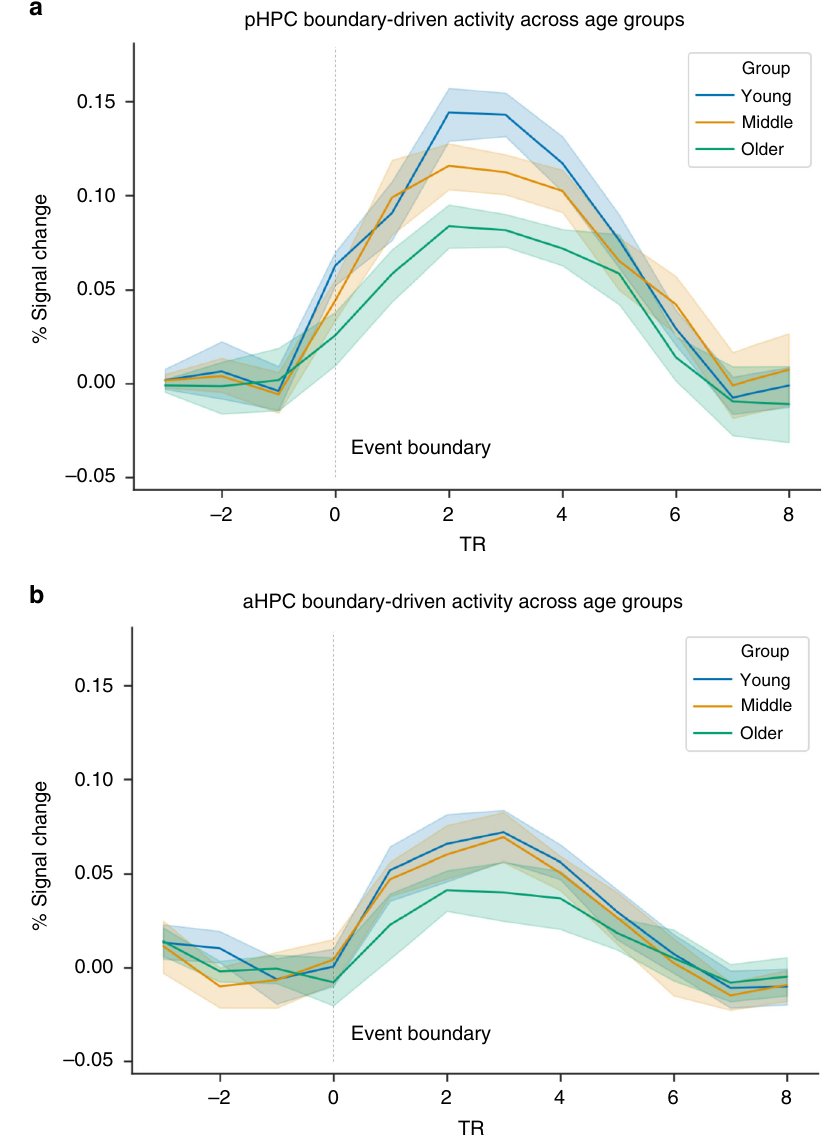
Fig. 2 Time-course of boundary-evoked response in posterior hippocampus across age groups. The time-courses of BOLD responses (FIR) are highly comparable across groups, indicating reduced pHPC boundary-evoked responses with age rather than a fundamentally different shape of the hemodynamic response. a pHPC, b (all p < 0.05 corrected), whereas the effect was driven by the (Fig. 4). Given the preferential connectivity of pHPC to the PM Network 26 , we predicted that PM regions, like pHPC, would be driven by event boundaries. Like pHPC, we found signi fi cant boundary-evoked activity throughout PM network regions: angular gyrus (ANG; t (545) = 37.26, p = 5.61e − 152 ), posterior medial cortex (PMC; t (545) = 32.69, p = 5.61e − 130 ), and para- hippocampal cortex (PHC; t (545) = 27.58, p = 5.61e − 105 ). Also in line with pHPC, we observed signi fi cant negative correlations with age in the same regions: ANG ( r = − 0.212, p = 5.56e − 07 ), PMC ( r = − 0.174, p = 4.37e − 05 ), PHC ( r = − 0.131, p = 0.002) (Fig. 5a, c, e). Broken down by groups, we found signi fi cant (Fig. 5g, i). Broken down into age groups, we found a signi fi cant differences in boundary-evoked activity across age groups in each effect of age in mPFC ( F (2,543) = 6.776, p = 0.001, η 2 = 0.025), region: ANG ( F (2,543) = 19.564, p = 6.24e − 09 , η 2 = 0.049), PMC ( F (2,543) = 8.705, p = 0.002, η 2 = 0.032), PHC ( F (2,543) = 3.295, p = 0.038, η 2 = 0.014) (Fig. 5b, d, f). In ANG and PMC, post hoc (Fig. 5h). Though the three group analysis revealed a similar contrasts revealed that both young and middle-aged adults had trend in MTG, it did not reach statistical signi fi cance signi fi cantly higher boundary-evoked activity than Older adults